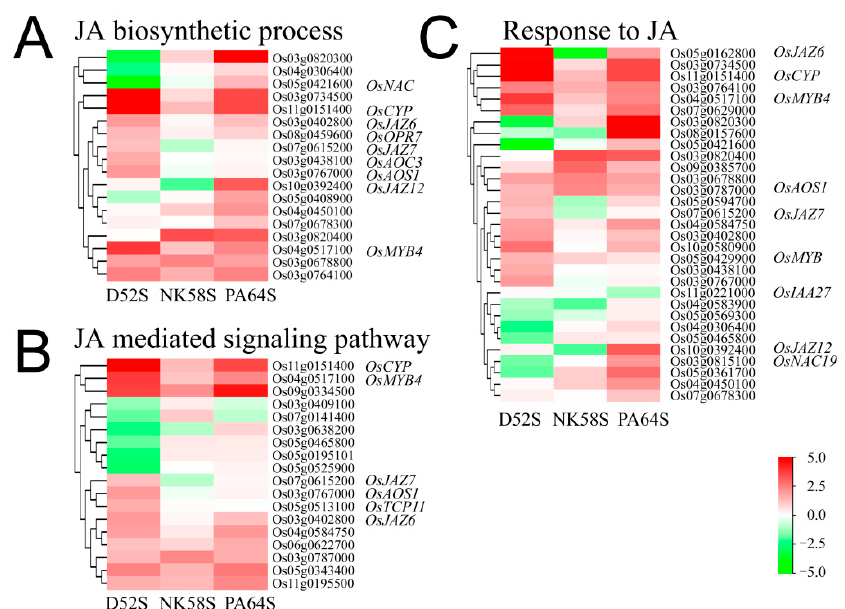
Figure 3. Heatmap analysis of gene expressions in JA biosynthetic process ( A ), JA signaling pathway ( B ) and response to JA ( C ) in 4th-stage-florets of PA64S, D52S and NK58S. Data are normalized and transformed by log 2 FC of gene expression in fertile plants, compared to those in sterile plants ( n = 3). FC, fold change; S/F, sterile/fertile plants.